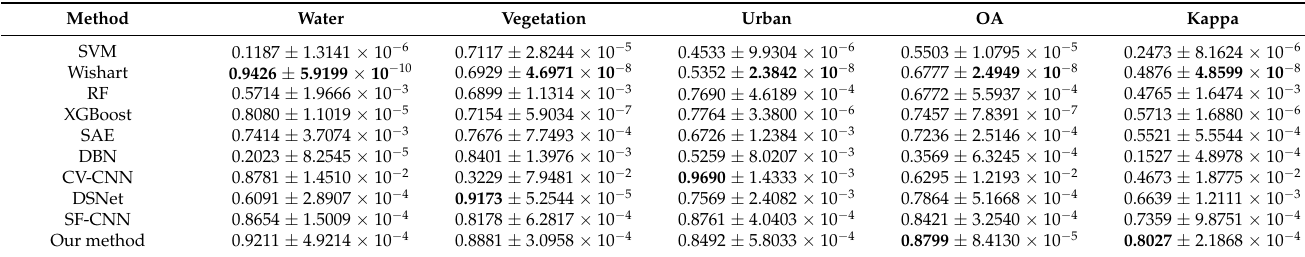
Table 4. Classification Results of Xi’an with Different Methods, where the highest mean and lowest variance for each category are marked in